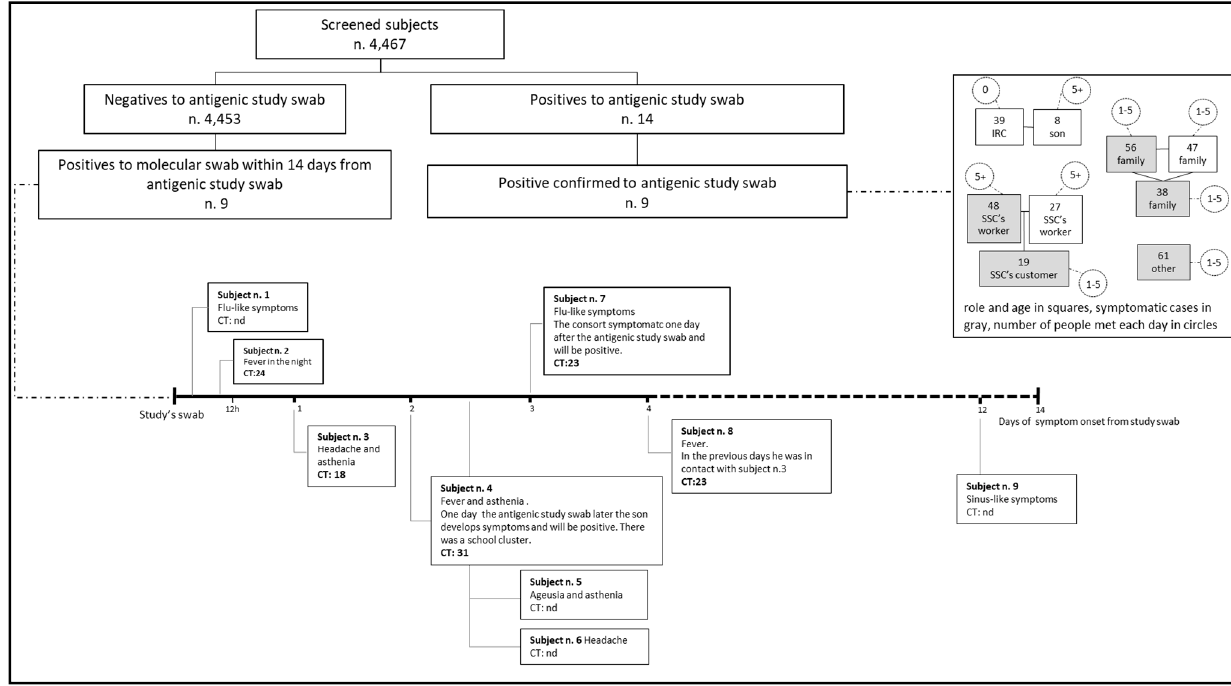
5 of 8 Table 2. Characteristics of the subjects tested positive for COVID-19 on screening test. Characteristics Subjects Tested Positive Confirmed on Mo- lecular Testing (n.9)